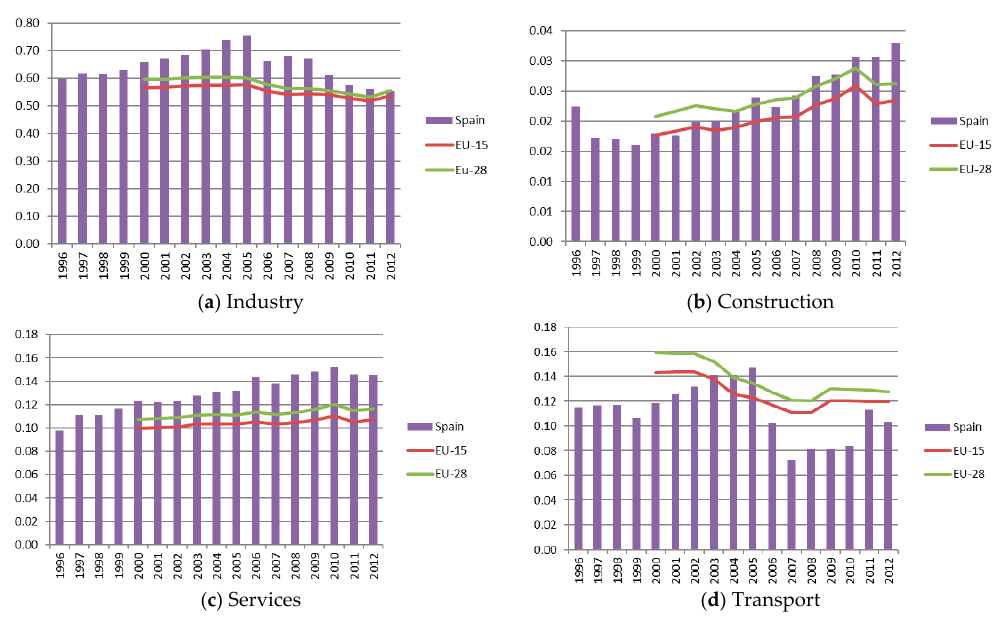
Figure 9. Sectorial intensity. Measured in GWh/million € GVA (2005). Source: Own calculations with Eurostat data.